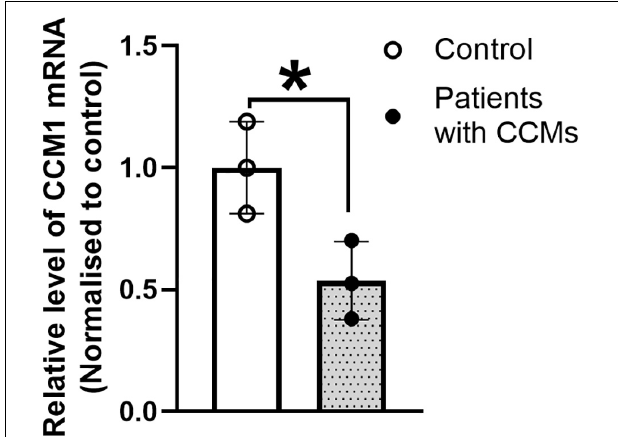
FIGURE 5 | The expression of CCM1 mRNA in the three patients from a Chinese family with FCCMs. Real time PCR result showed a significant reduction of CCM1 mRNA in the blood lymphocytes of the three patients (The proband III4, her mother II5 and her uncle II7) compared with three healthy controls. Data = mean ± SEM, * p <